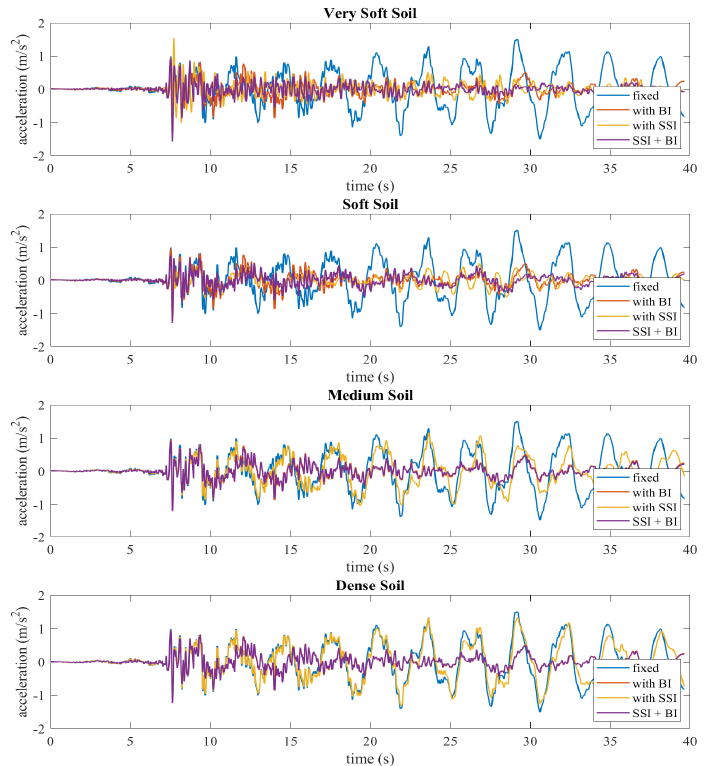
Figure 8. Top story acceleration–time history of forty ‐ story buildings (Imperial Valley, 1979).